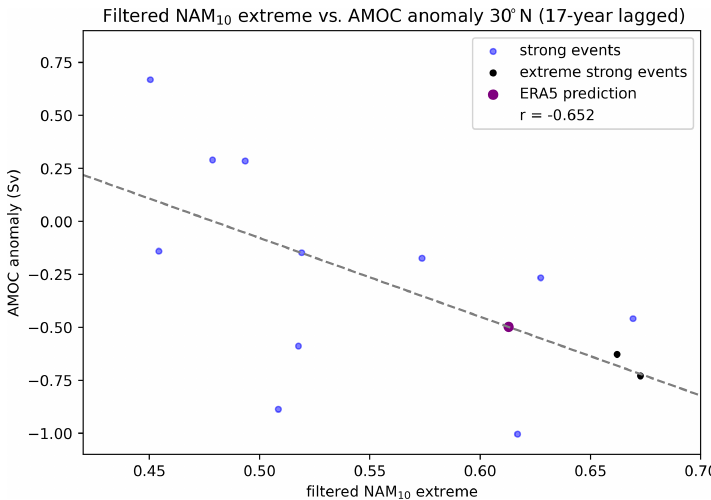
Figure 14. Same as Fig. 13d but for AMOC responses at 30 ◦ N. A scatterplot of filtered NAM 10 index values occurring at persistent strong NAM 10 intervals throughout the whole UKESM simulation ( y axis) against AMOC anomalies at 30 ◦ N lagged 17 years after the persistent intervals’ central year ( x axis). Blue points indicate persistent intervals, and black dots represent the two intervals displayed in panel (b) . The dotted line represents the linear line of the best fit for the points in black and blue. Also included is the 17-year lag AMOC anomaly predicted by projecting the regression coefficients used to construct the linear fit onto the maximum smoothed NAM 10 index in the ERA5 dataset (purple